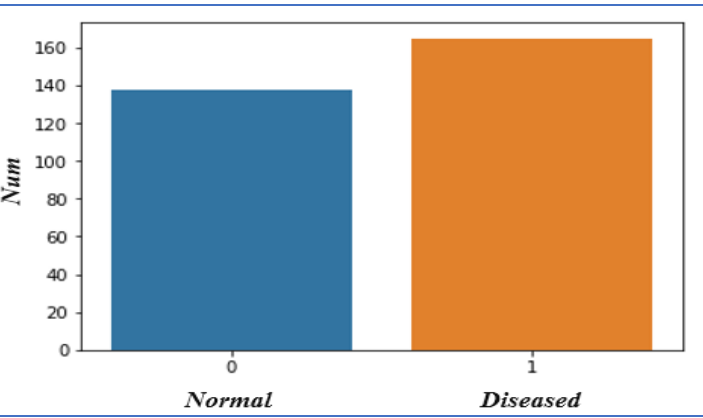
Figure 3. Heart Disease Status.